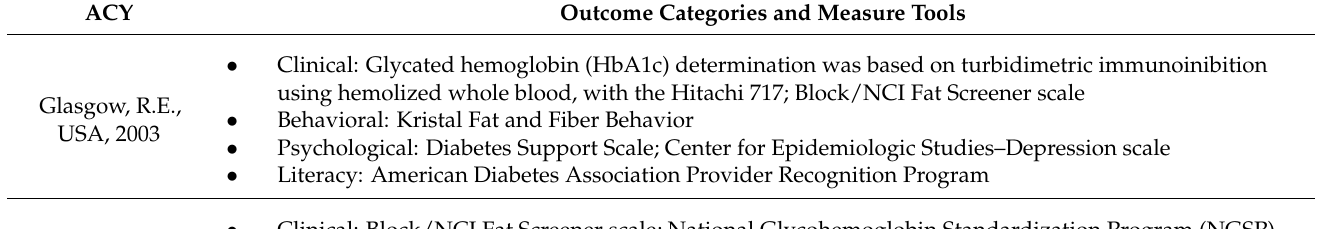
Table 3. Summary of interventions’ outcomes and measures used in the selected studies. Outcome Categories and Measure